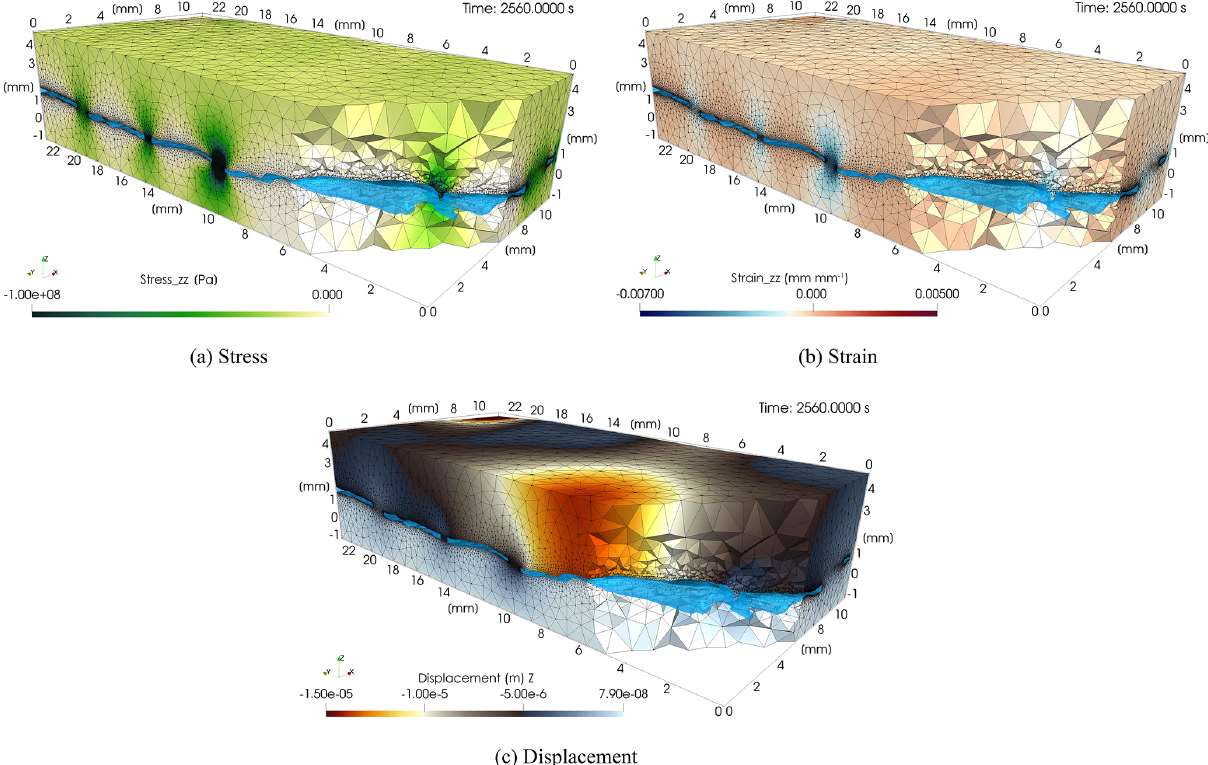
Figure 7. Stress, strain, and displacement in the matrix-fracture system after after applying 17MPa normal stress at the top surface.